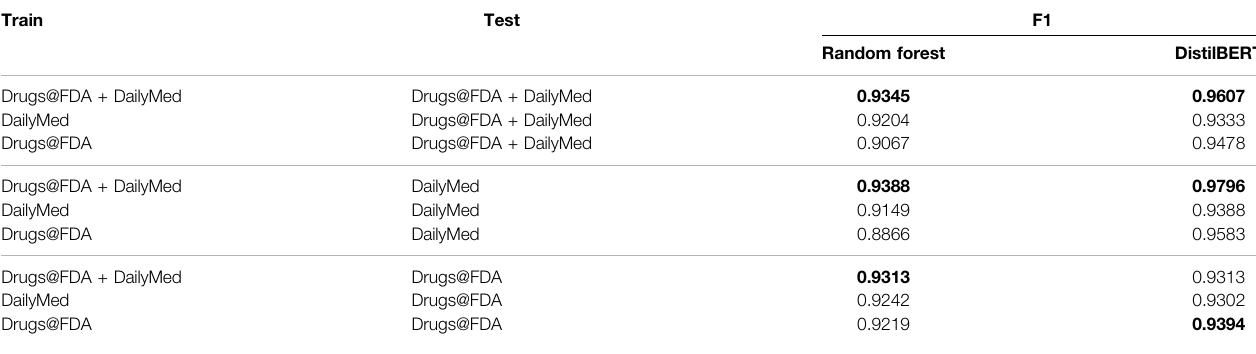
TABLE 6 | Result with different combinations of training and testing on various datasets (Best model performance of each combination is in bold).